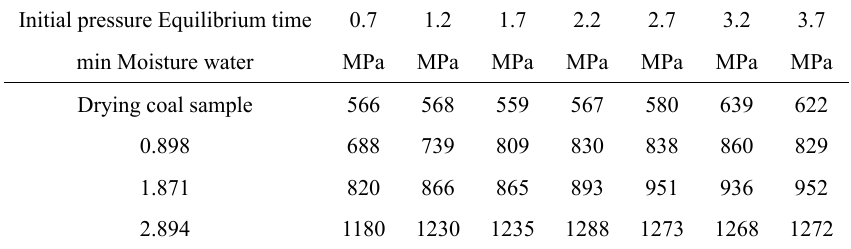
Comparison of adsorption times for different levels of moisture